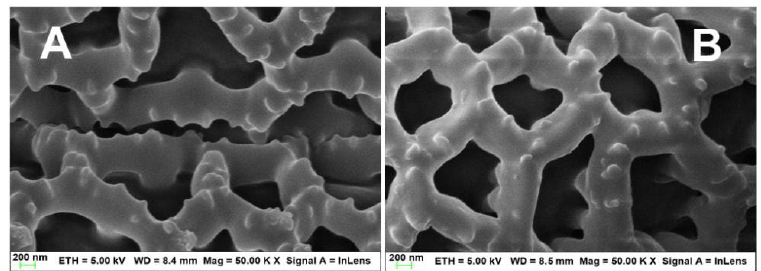
Figure 1. FE-SEM images of olive pollen incubated at 20 ( A ) and 40 °C ( B ) for 62 h.